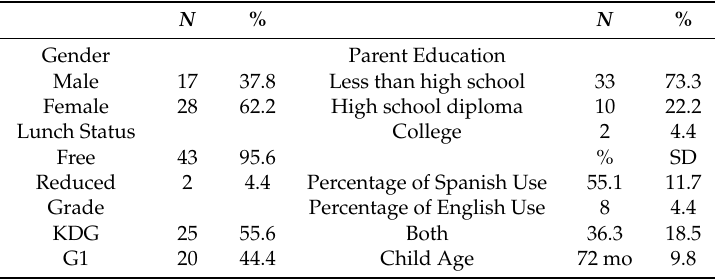
Table 2. Socio-Demographic Characteristics of Participants ( N = 45).